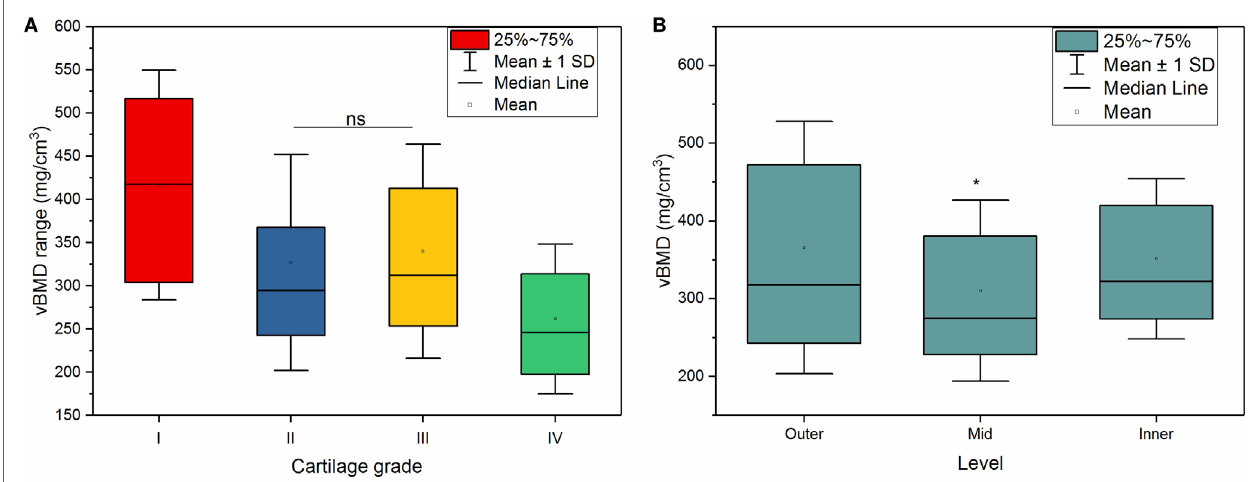
FigUre 4 | (a) Volumetric bone mineral density (vBMD) of osteoarthritis samples according cartilage grading. A significant decrease in vBMD of subchondral bone with cartilage grading was observed at all grades ( p < 0.001), except between grade II and III (ns, no significant difference). (B) vBMD according to depth. Mid levels showed significantly lower vBMD compared to outer and inner levels; * p < 0.001.